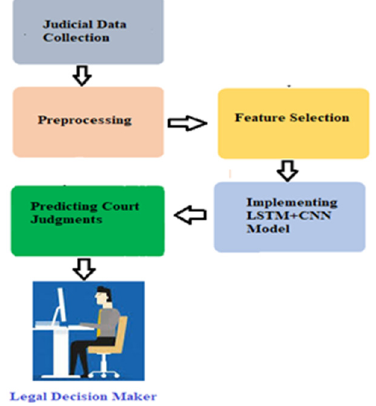
Figure 1. Proposed system for predicting court judgments.